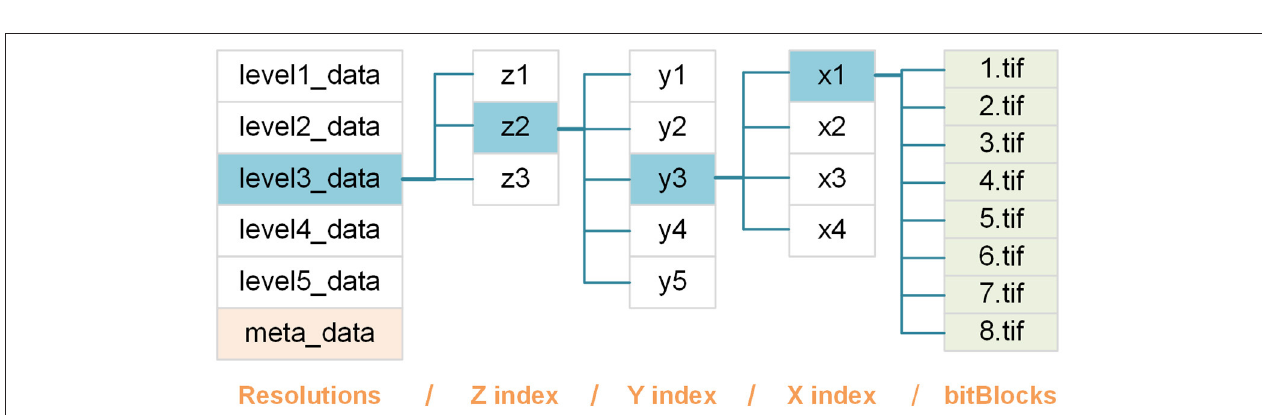
FIGURE 2 | Schematic of the webTDat format. We take a set of whole mouse brain data that has been converted to webTDat format as an example. The bitBlocks are organized as a four-level hierarchy of folders according to their levels and locations in the data space.